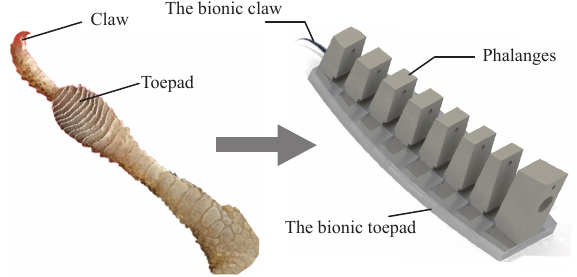
Figure 7. Simplified model of the